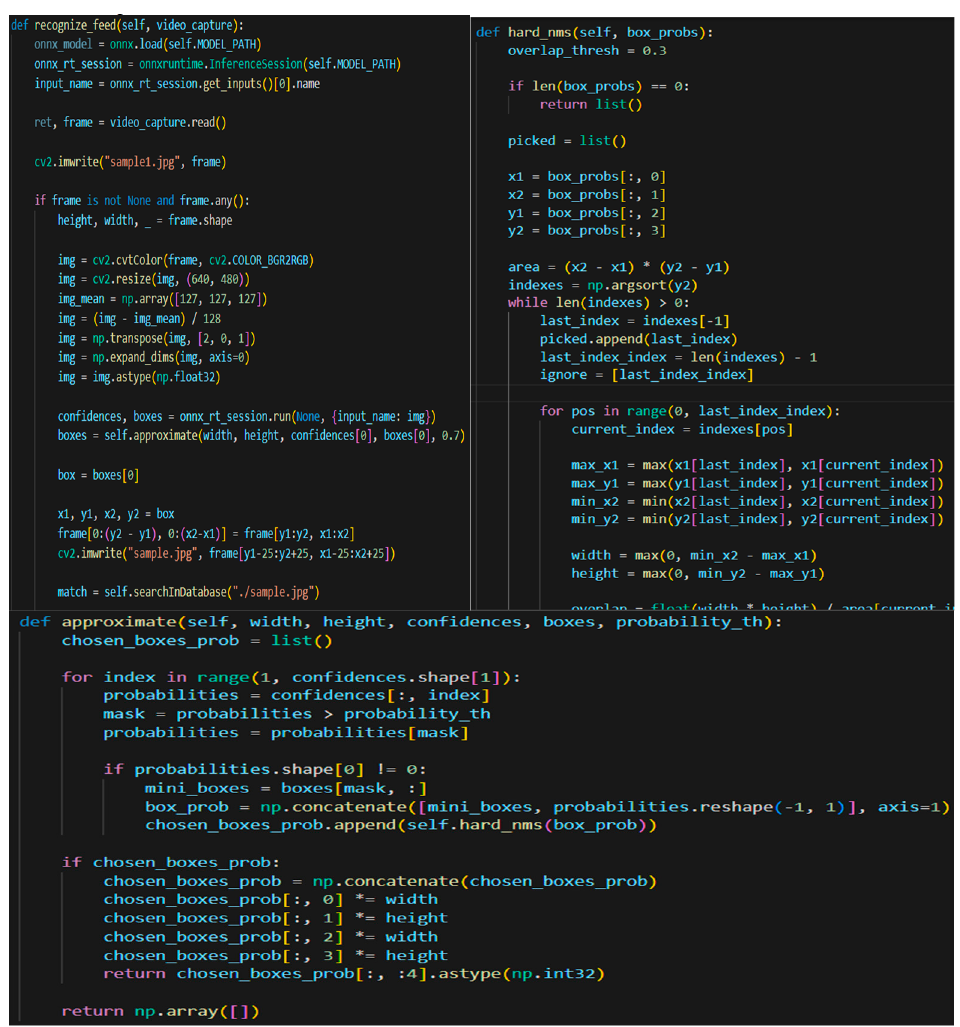
Figure 11. Code Samples of FR class.